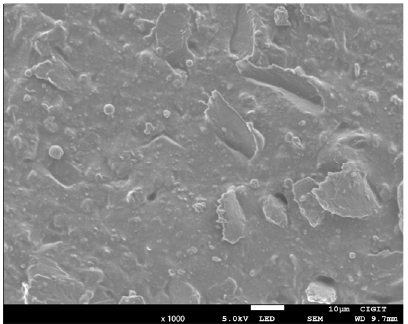
Figure 2. SEM diagram of the graphene and silicone rubber matrix.